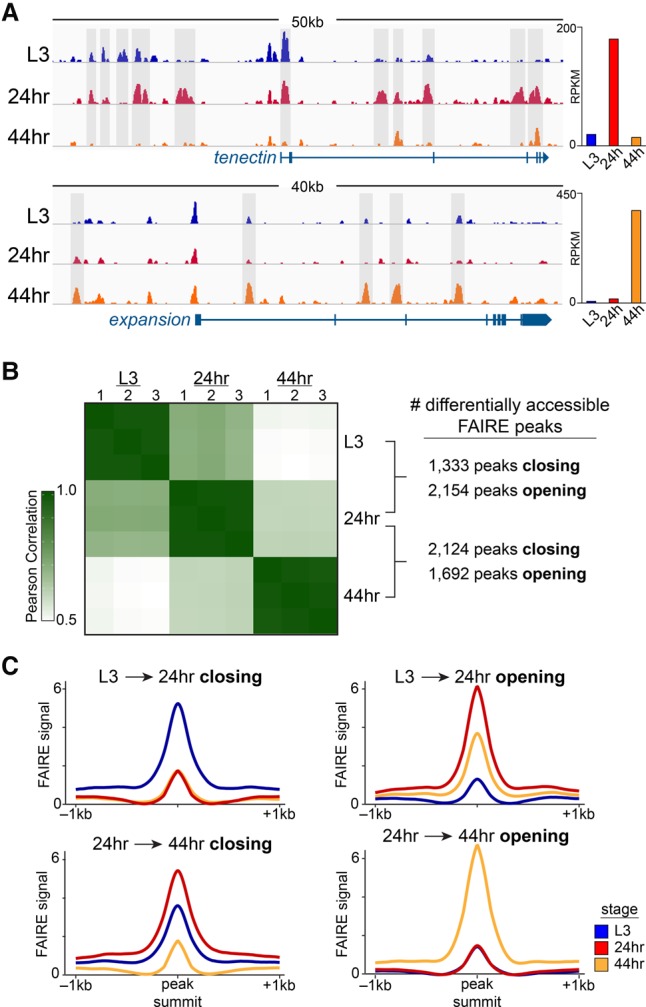
Open chromatin profiles are temporally dynamic in pupal wings. (A) Browser shots of FAIRE-seq signal (Z-score) at the tnc and expansion loci. Temporally dynamic open chromatin sites are highlighted with gray shading. Bar plots show the RNA-seq signal for each gene over time. (B) Heat map of the Pearson correlation coefficients between FAIRE-seq replicates. The number of differentially accessible FAIRE peaks out of the top 7699 peaks for each consecutive time point is shown. (C) Line plots of the average FAIRE-seq signal across all categories of differentially accessible FAIRE peaks. The L3 signal is shown in blue, 24 h is shown in red, and 44 h is shown in orange.